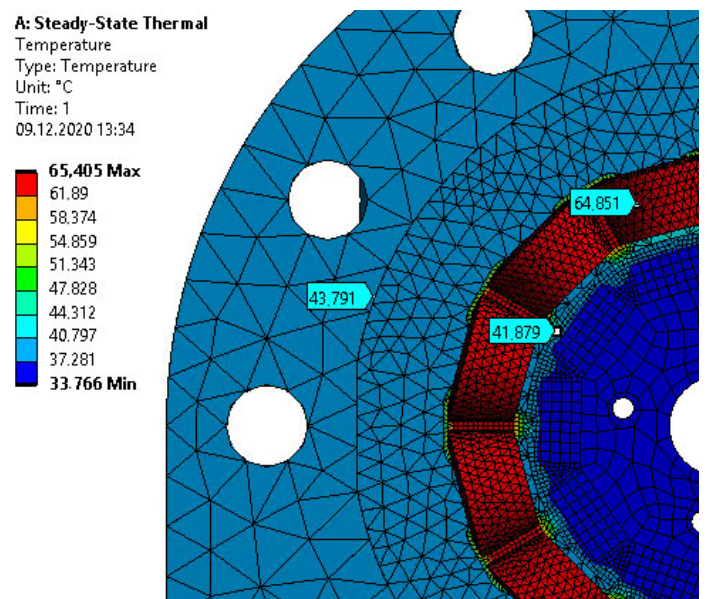
Figure 12. FEA simulation results of the obtained equivalent conductivity